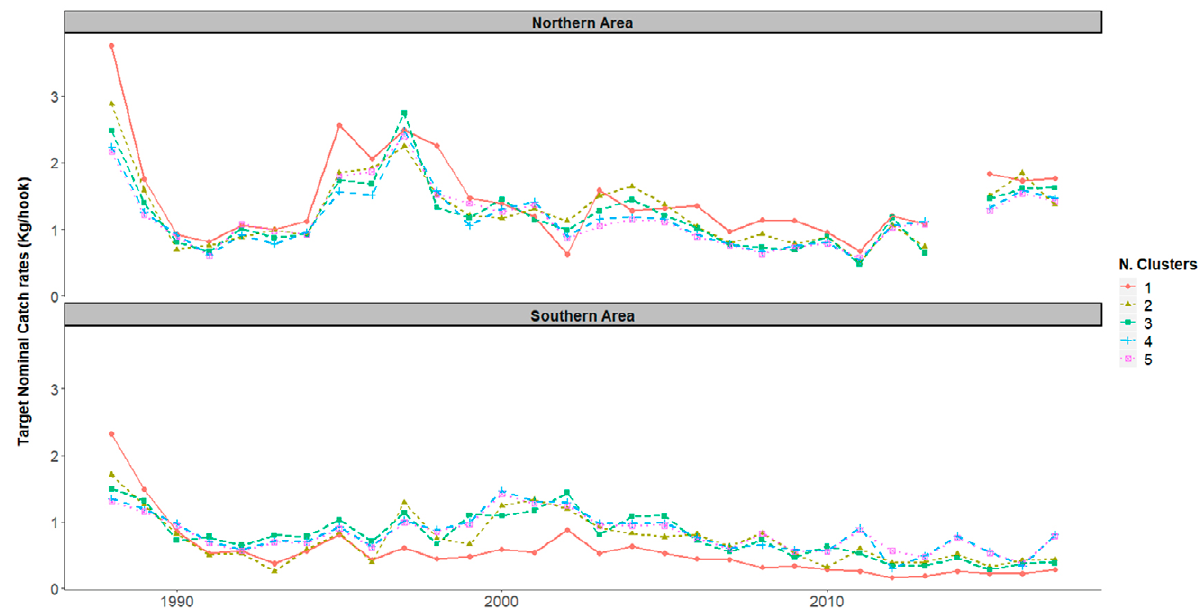
Fig. 5. – Nominal catch rates of pink cusk-eel caught as targeted and depending on a fixed tactic (Scenario 1) used across years. Time series were standardized to their mean.